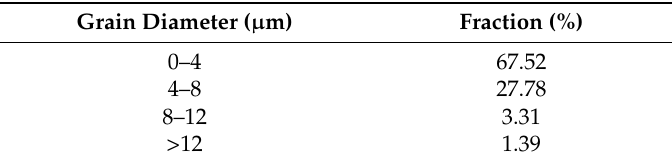
Table 3. Grain size of 45CrNiMoVA.